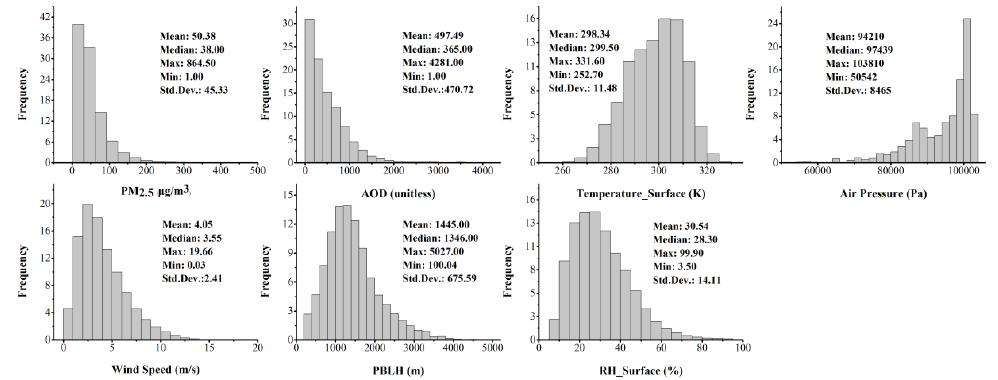
Figure 2. Histograms and descriptive statistics for PM 2.5 , AOD, surface temperature, atmospheric pressure, wind speed, planetary boundary layer height (PBLH), and surface relative humidity (RH) in the model